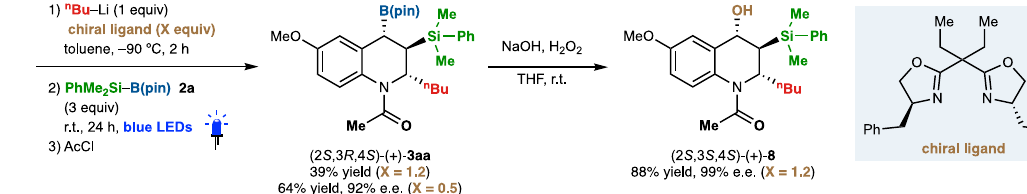
Fig. 4 | Silaborated tetrahydroquinolines as synthetic platforms and an asymmetric synthesis. a Use of silaborated tetrahydroquinolines as synthetic platforms. b Asymmetric synthesis of 3-silyl-4-boryl-1,2,3,4-tetrahydroquinoline. Yields were determined by 1 H-NMR